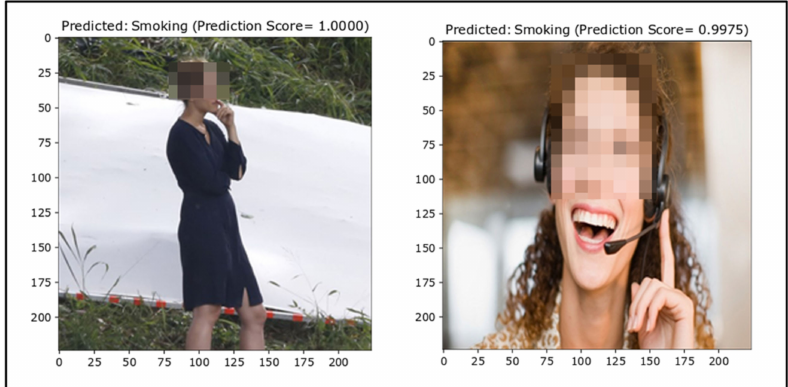
Figure 11. False positives (ground truth =